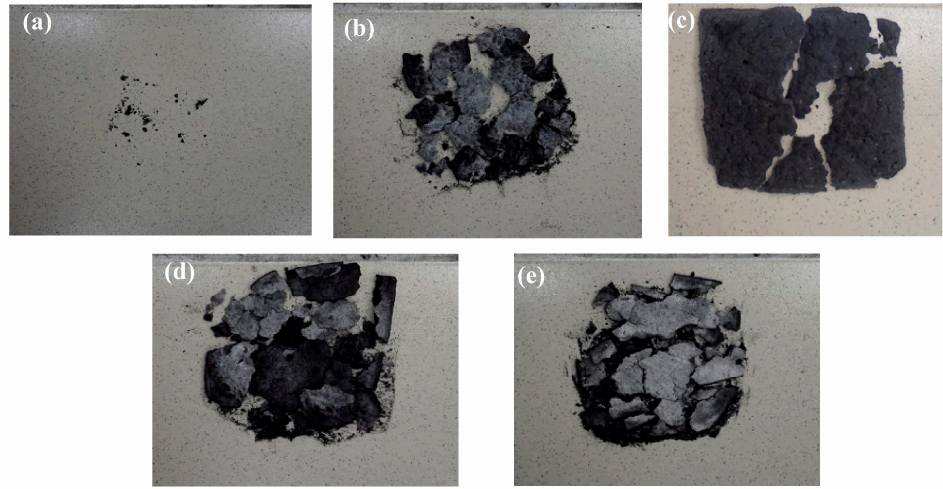
Figure 8. Digital images of the residues for ( a ) P/15B, ( b ) P/15B/10PA-PEI, ( c ) P/15B/15PA-PEI, ( d ) P/15B/10PA-Arg and ( e ) P/15B/15PA-Arg after CCT.